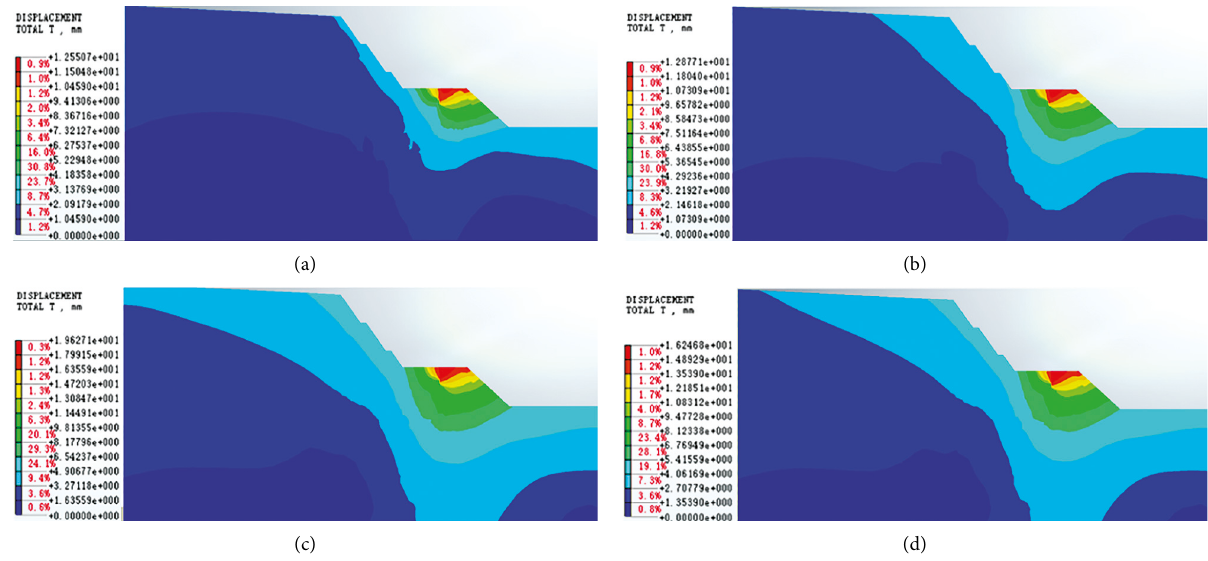
Figure 11: Time-displacement nephograms after the detonation of the fourth blasthole. (a) 225 ms. (b) 240ms. (c) 255ms. (d)